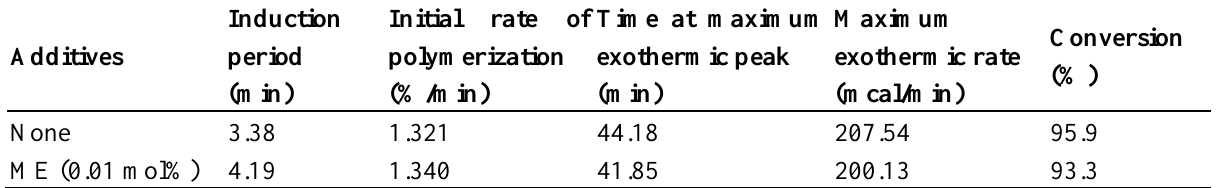
2. Polymerization of methyl methacrylate (MMA) in the presence of 2-mercaptoethanol (ME).